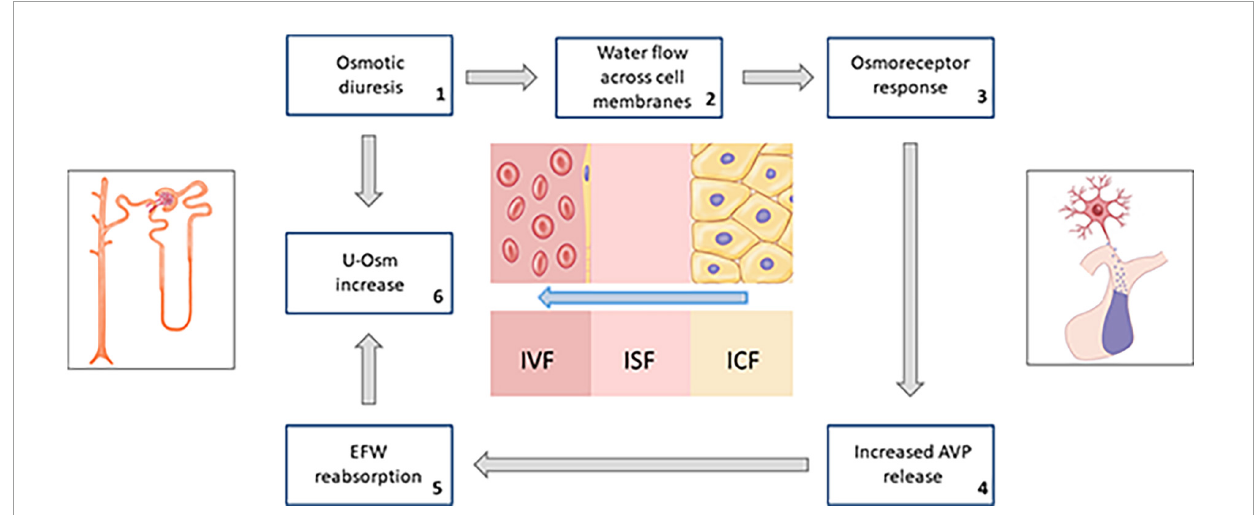
FIGURE5 Schematic summary of the hypothesized response of osmoreceptors to water flow across cell membranes due to persistent osmotic diuresis during treatment with SGLT2i (AVP, arginine-vasopressin; EFW, electrolyte-free water; u-Osm, urine